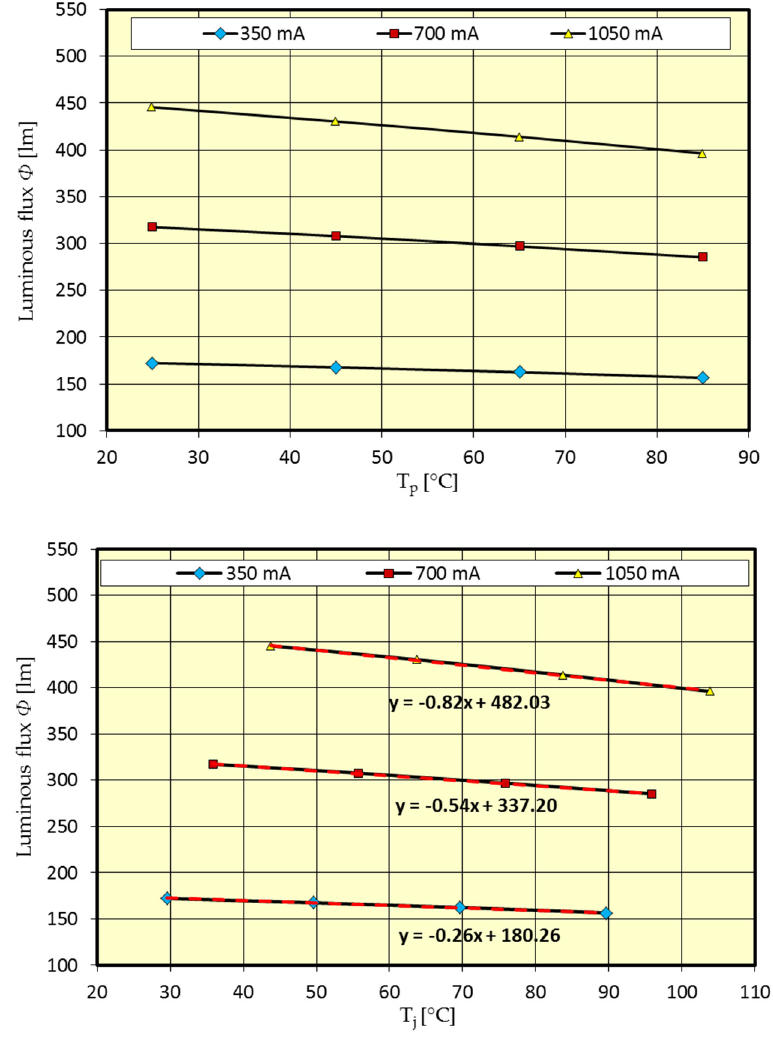
Figure 2. The studied LED source ( a ), characteristic temperatures ( b ) and test stand of the GL Optic Company ( c